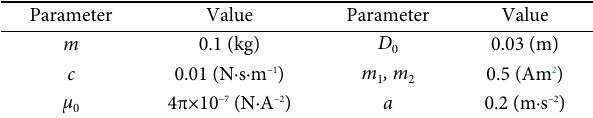
Table 1 Parameters of the nonlinear TENG Parameter